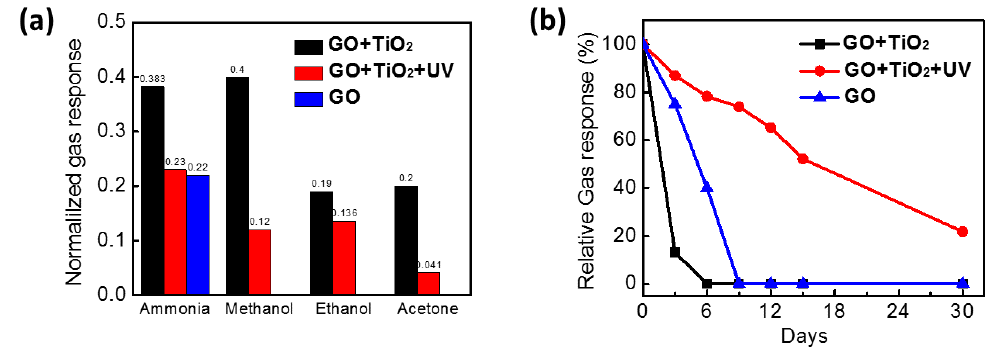
Figure 7. ( a ) The compiled gas response and ( b ) the long-term response of UV-treated and non-treated GO/TiO 2 composite film to ammonia